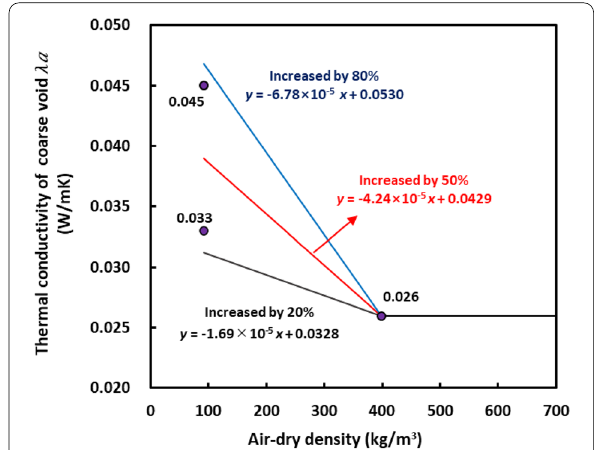
Fig. 10 Thermal conductivity of the coarse void varying with a waste mushroom bed air-dry density